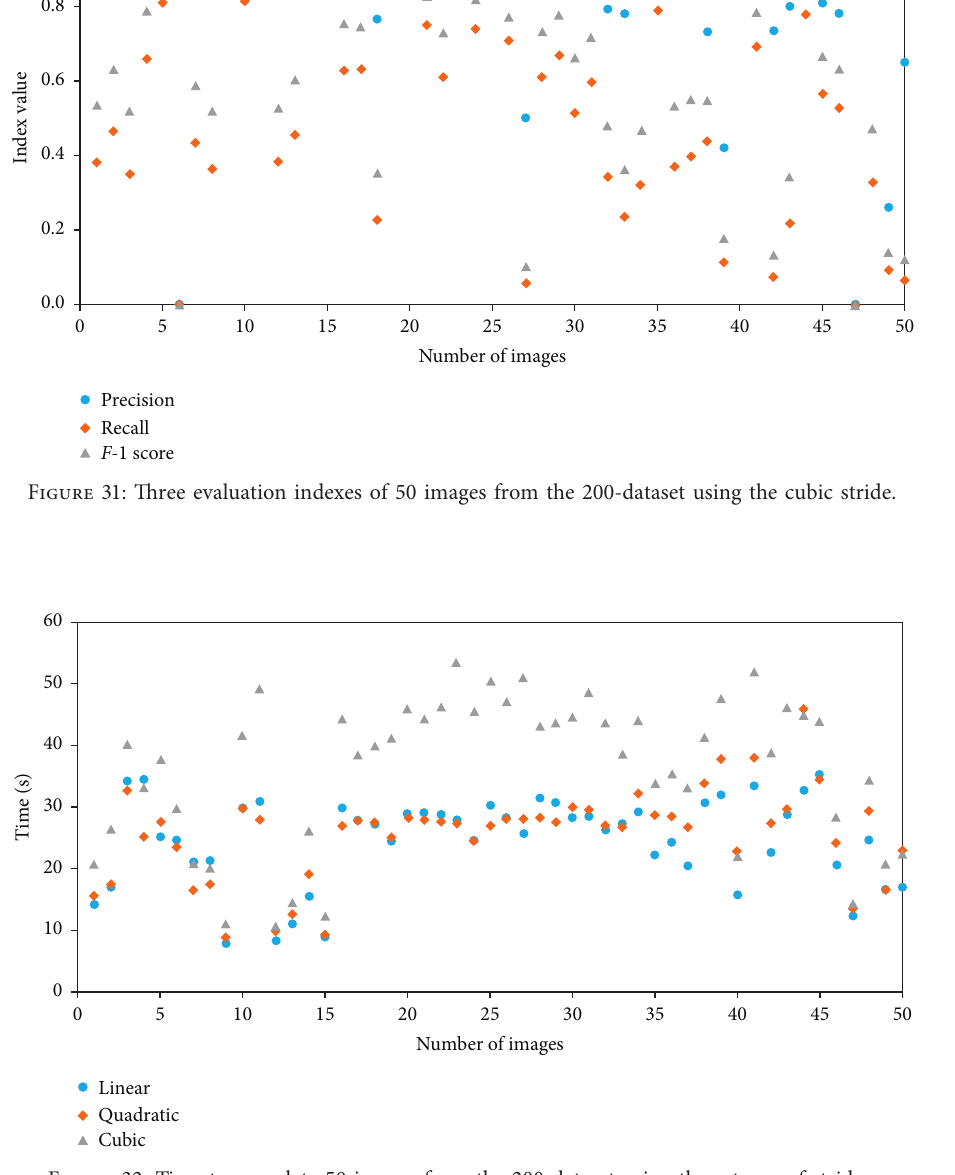
Figure 32: Time to percolate 50 images from the 200-dataset using three types of strides.